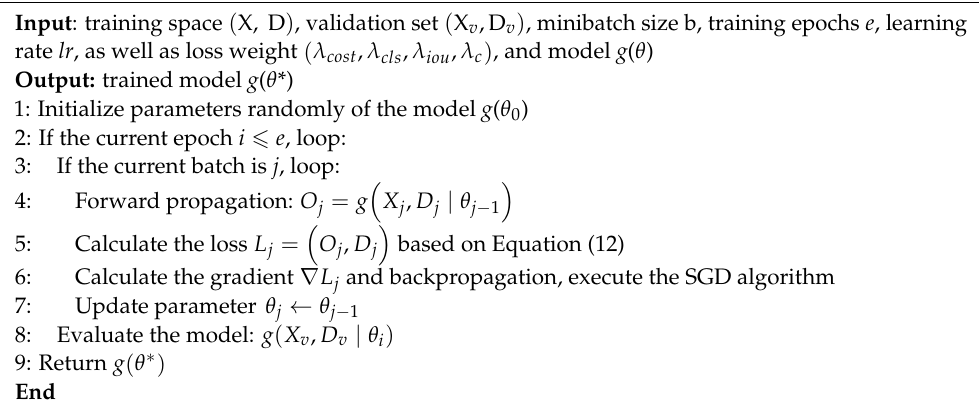
Algorithm 1: Training direct-type cost-sensitive